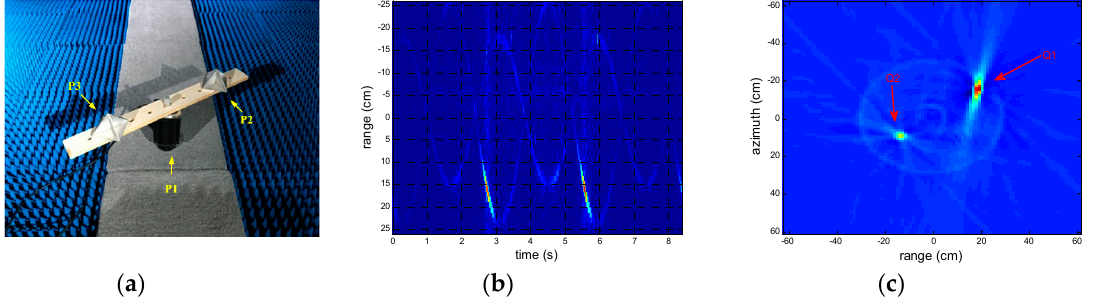
Figure 2. This is an experimental target: ( a ) with the rotating targets, there are two four-side corner reflectors driving by a motor; ( b ) the RPs of the rotating target (SNR = 0 dB); ( c ) the inverse Radon transform of ( b ).